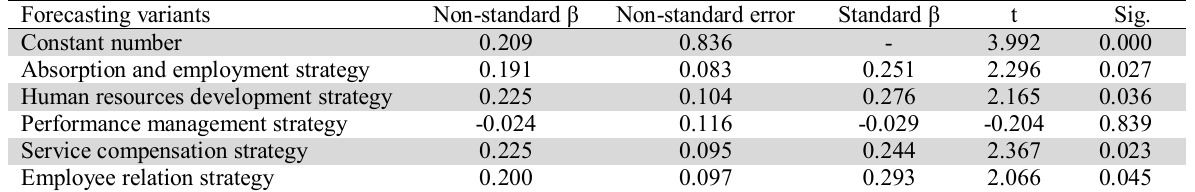
Regression analysis coefficient and non-standard human resources strategies and their components for forecasting organizational performance Forecasting